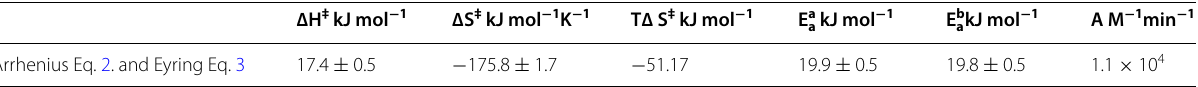
∆G ‡ 68.59 1.02 at 18 °C = ± a From Arrhenius Eq. 2